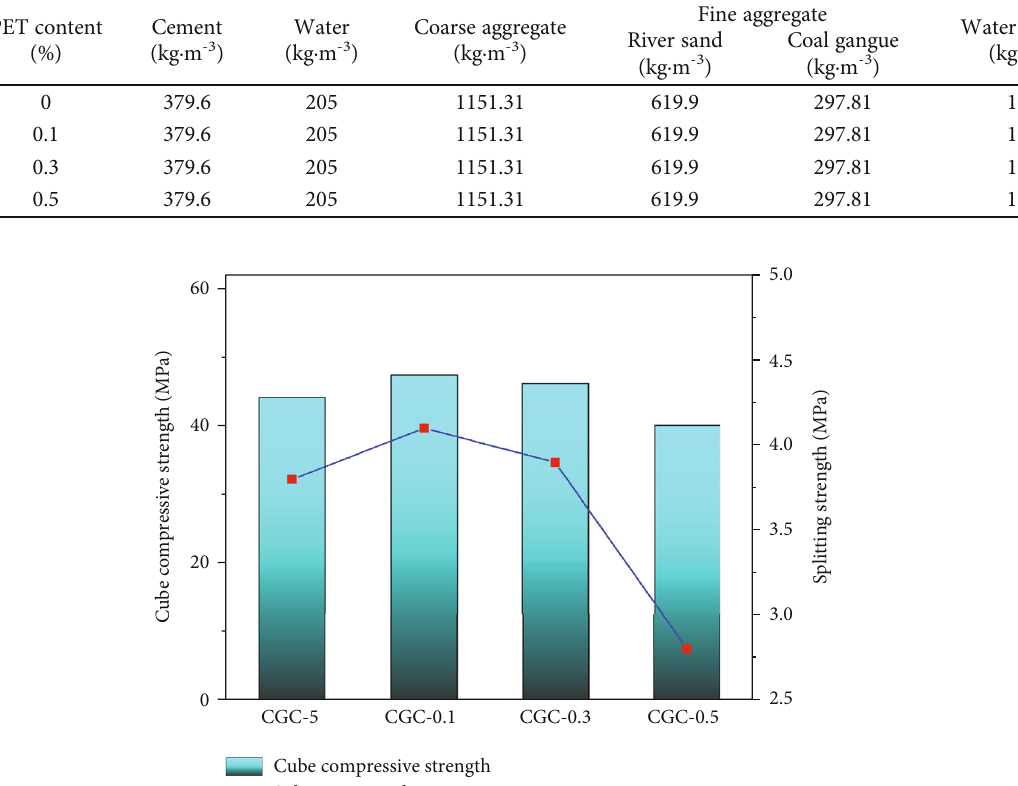
Table 2: Concrete mix proportion.